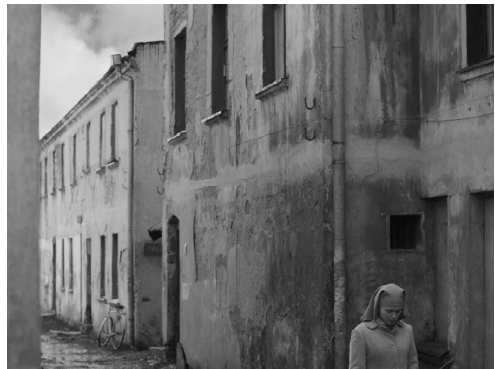
Figure 12. Ida in an unbalanced frame. Figure 13. Ida’s face falls off frame.